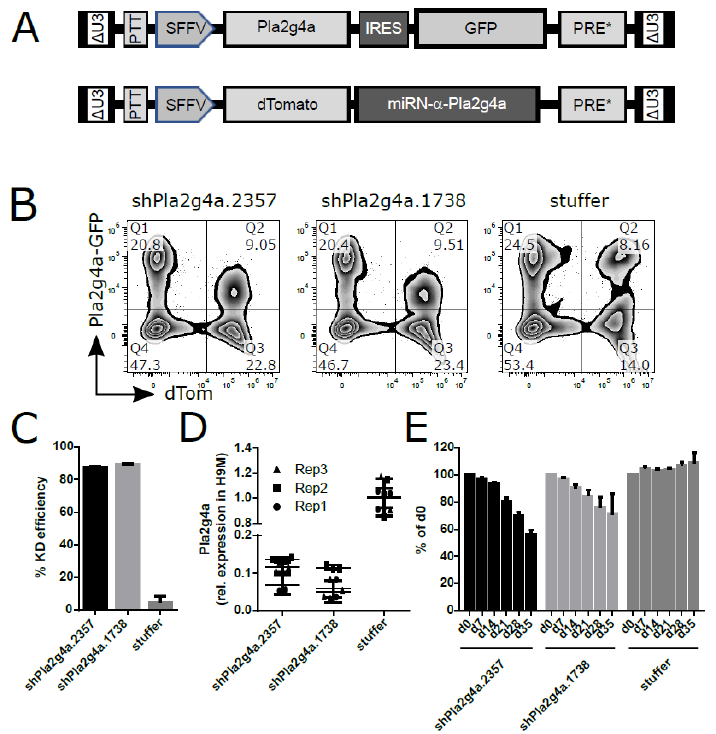
Figure 4. Pla2g4a knockdown impairs H9M cell growth. ( A ) Schematic representation of (top) a lentiviral vector co-expressing Pla2g4 and GFP via an internal ribosome entry site (IRES) and (bottom) an shRNA expression vector co-expressing dTomato and a mir-N embedded hairpin against Pla2g4a under control of the SFFV promoter. ( B ) Representative flow cytometric analysis plots of two shRNAs against Pla2g4a , which downregulate the signal of a PLA2G4A-GFP reporter. Transduction with an empty shRNA vector (stuffer) does not cause loss of Pla2g4a reporter expression. ( C ) Calculation of the knockdown efficiency of two shRNAs as well as of the “stuffer” control vector based on data from the reporter assay from ( B ). ( D ) Validation of Pla2g4a knockdown efficiency by RT-qPCR in three different H9M lines (Rep1, Rep2, and Rep3), in comparison to a non-targeting (stuffer) miR-N backbone. ( E ) Depletion of shRNA- α - Pla2g4a transduced H9M cells over time. Data shown from one exemplary experiment with three data points per vector. Data were normalized to the gene marking rate at the first measurement (d0) seven days after the initial transduction.